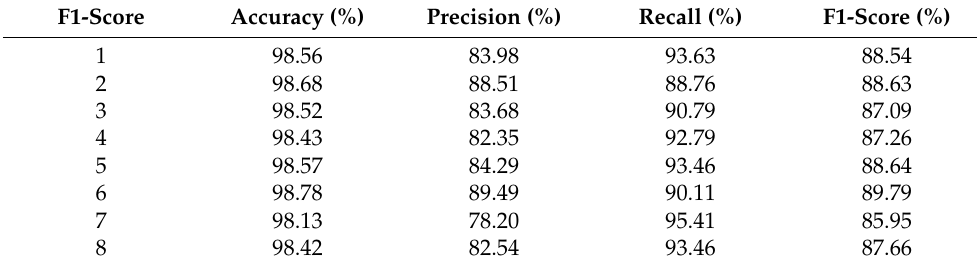
Table 4. Performance with outlier thresholds determine from only 10% of the outlier